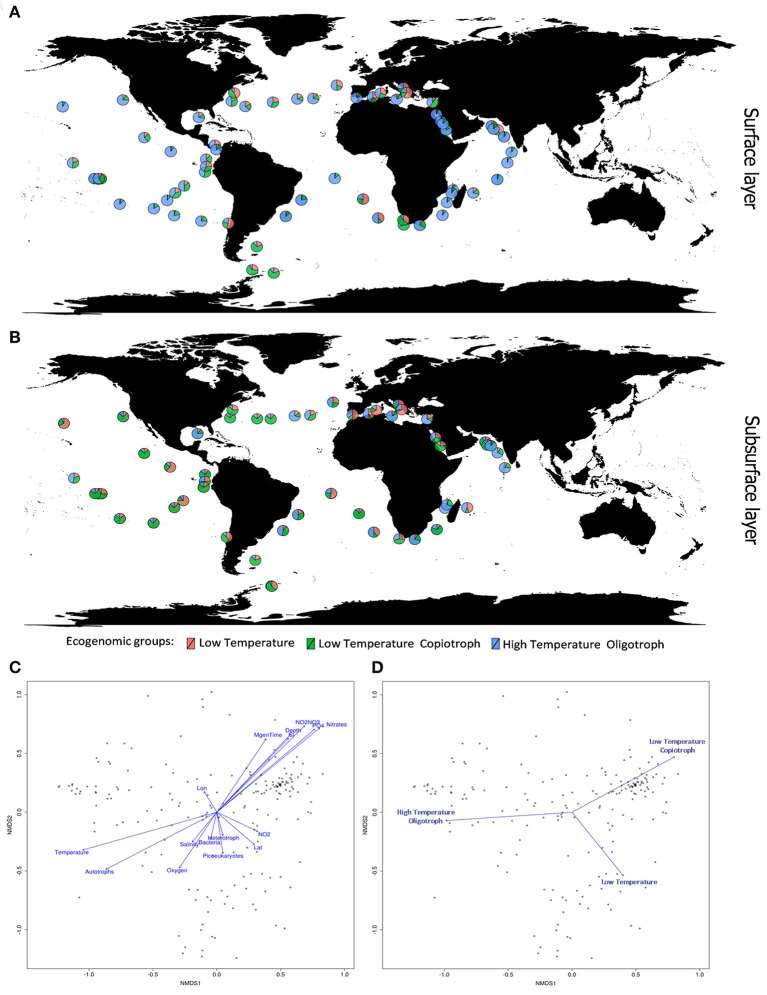
Ecogenomic analysis of Cyanobacteria in global marine environments. (A) Distribution of the dominant ecogenomic groups (Low Temperature group; Low Temperature Copiotroph group; and High Temperature Oligotroph) along the Tara Ocean transect sampling from surface layer (5 m). (B) Distribution of the dominant ecogenomic groups along the Tara Ocean transect sampling from subsurface layer (>5 m). (C) Non-metric multidimensional scaling (NMDS) analysis of the marine metagenomes and environmental parameters. Ordination plot of physicochemical parameters. Dots indicate the metagenomes samples. Distances were calculated based on the Bray-Curtis Method. NMDS stress value = 0.15. (D) Non-metric multidimensional scaling (NMDS) analysis of the marine metagenomes and environmental parameters. Ordination plot of ecogenomic clusters. Dots indicate the metagenomes samples. Distances were calculated based on the Bray-Curtis Method. NMDS stress value = 0.15.